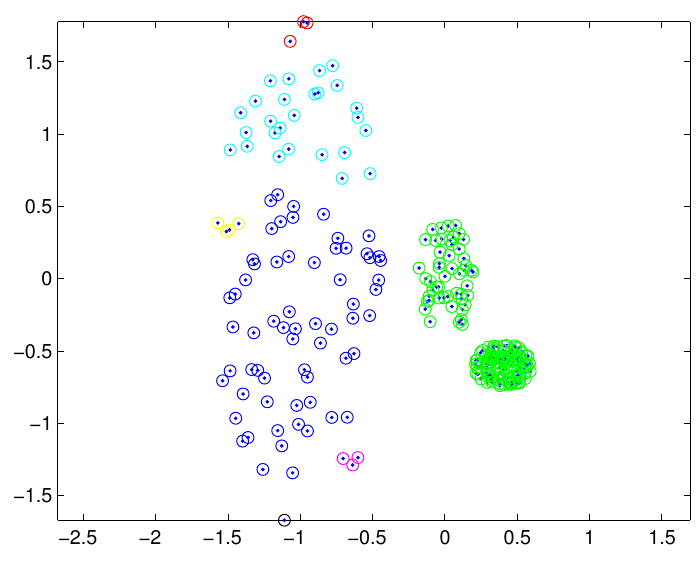
Figure 3. Partition by DP for a bigger